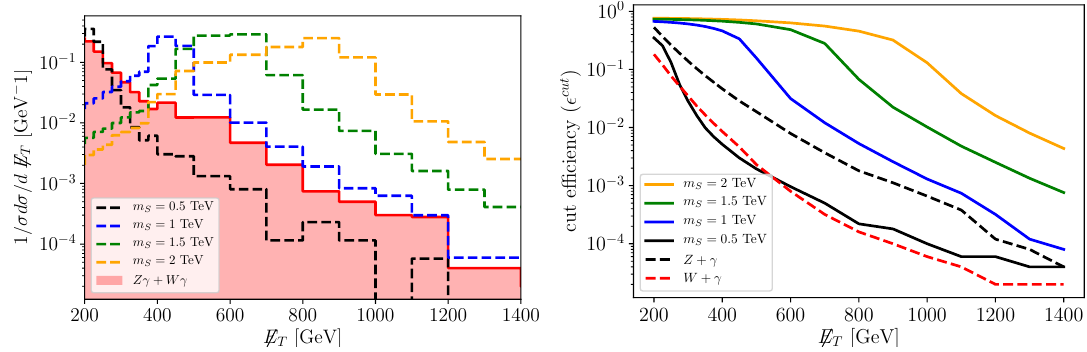
Figure 5 . The normalized =E distribution for signals and the main backgrounds are displayed in T the left panel. In the right panel, we show the cut e(cid:14)ciency in terms of the =E threshold. T For each point of the parameters space that passed all the constraints, we calculate the signal signi(cid:12)cance, N , with a metric that interpolates the gaussian and poissonian regimes (cid:27) at the same time it allows for including systematic e(cid:11)ects in the background normalization without overestimating the signi(cid:12)cance [71, 72] (cid:12)xing a 10% systematic uncertainty in the total background normalization which seems to be realistic in view of the estimates from ref.